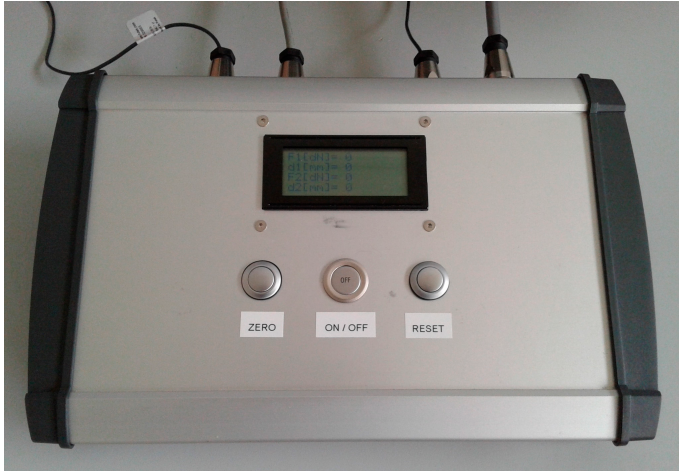
Figure 4. Electronic device for signal conditioning and data processing.